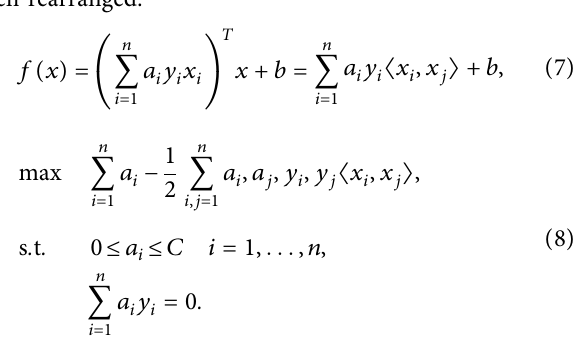
Figure 11: SVM linear binary classification